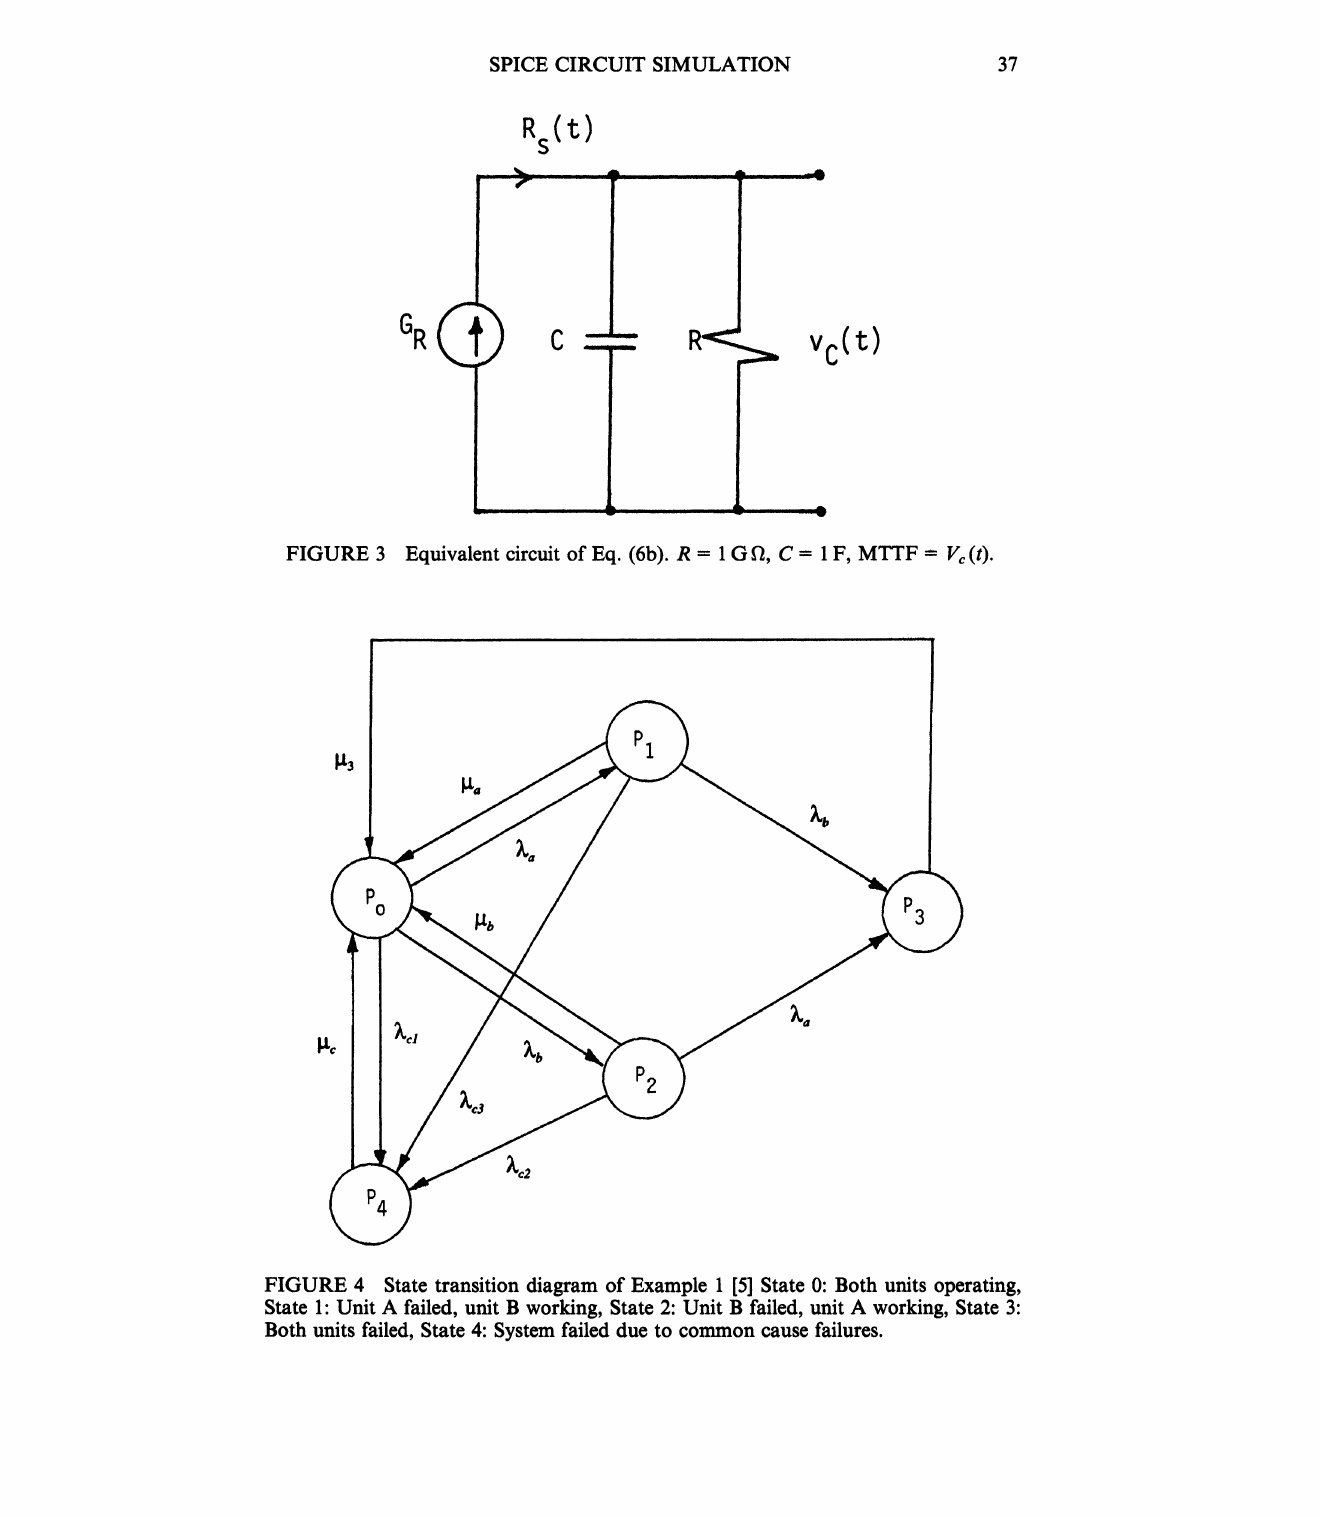
FIGURE 4 State transition diagram of Example [5] State 0: Both units operating, State 1: Unit A failed, unit B working, State 2: Unit B failed, unit A working, State 3: Both units failed, State 4: System failed due to common cause